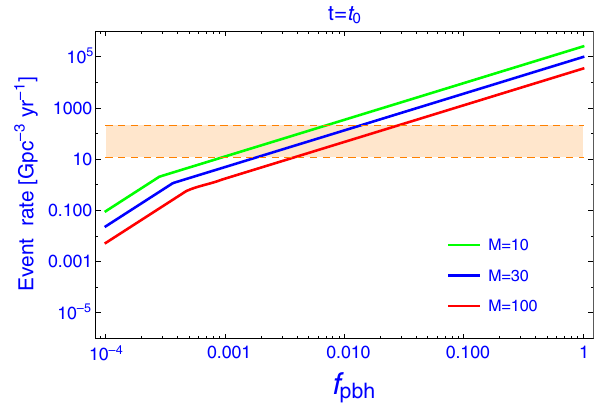
Fig. 3 Event rate of single mergers of PBH binaries with the mass M = 10 (green), 30 (blue) and 100 (red) in M (cid:2) at the present time as a function of the PBH abundance. The merger rate of R = 12– 213 Gpc − 3 year − 1 , inferred by the LIGO and Virgo Collaboration, is shown as the shaded region colored orange